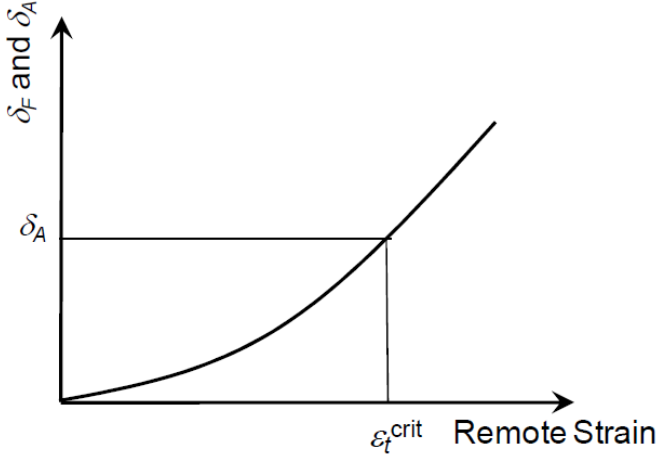
Figure 7. Schematic illustration of a crack-driving force relation.